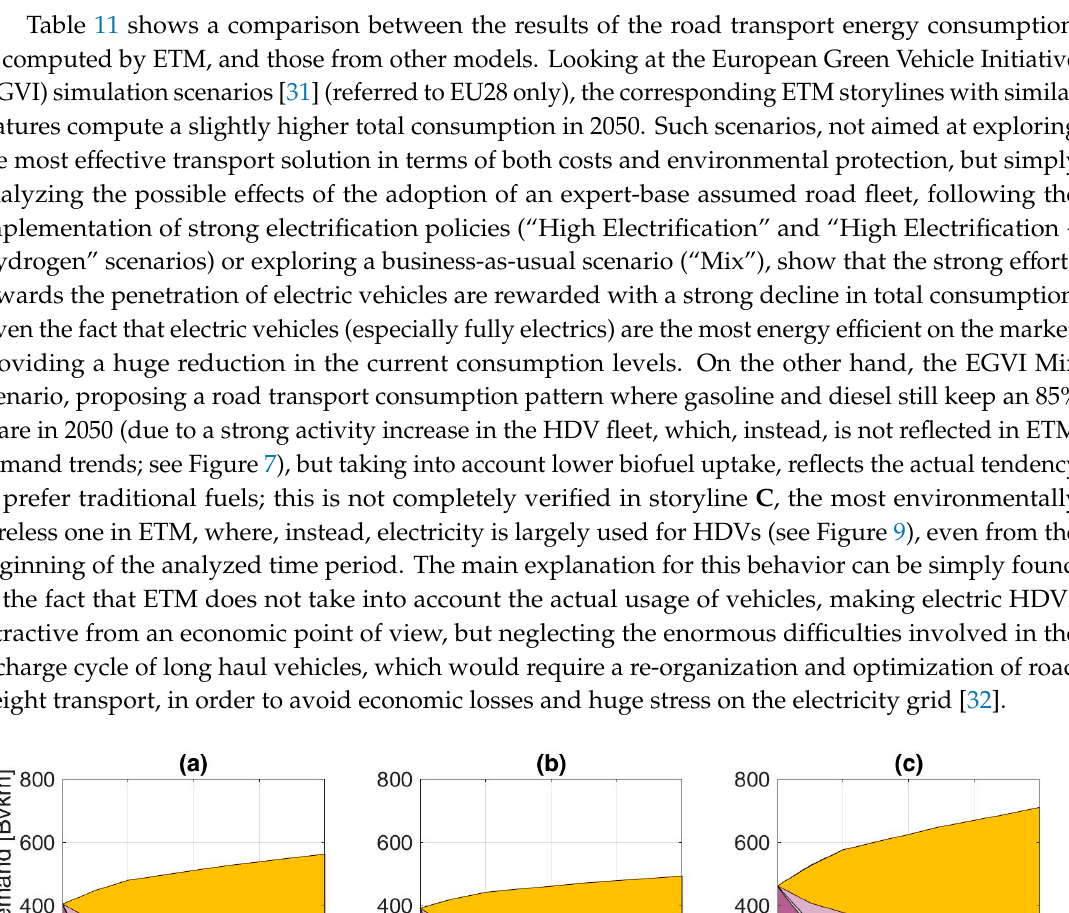
Figure 10. LDV fleet composition in the three analyzed storylines: A ( a ), B ( b ) and C ( c ). Table 12 shows the comparison of results concerning HDVs only: while transport and environment [40] are in line with ETM results, forecasting a 100% alternative fuel power HDV fleet by 2050, the 2016 edition of the EU Reference (business as usual) scenario only accounts for a 3% penetration of alternative fuel vehicles (AFV) in the heavy-duty fleet by 2030 (even in ETM storyline C ; due to the strong uptake of biofuels, alternative fuels are able to cover 26% of the demand). As already explained in Section 4.1, the EU Reference scenario highlights how difficult the implementation of effective environmentally friendly initiatives for long-haul vehicles is in ensuring that there is no impact on the normal activity of goods transport. Furthermore, the first ever